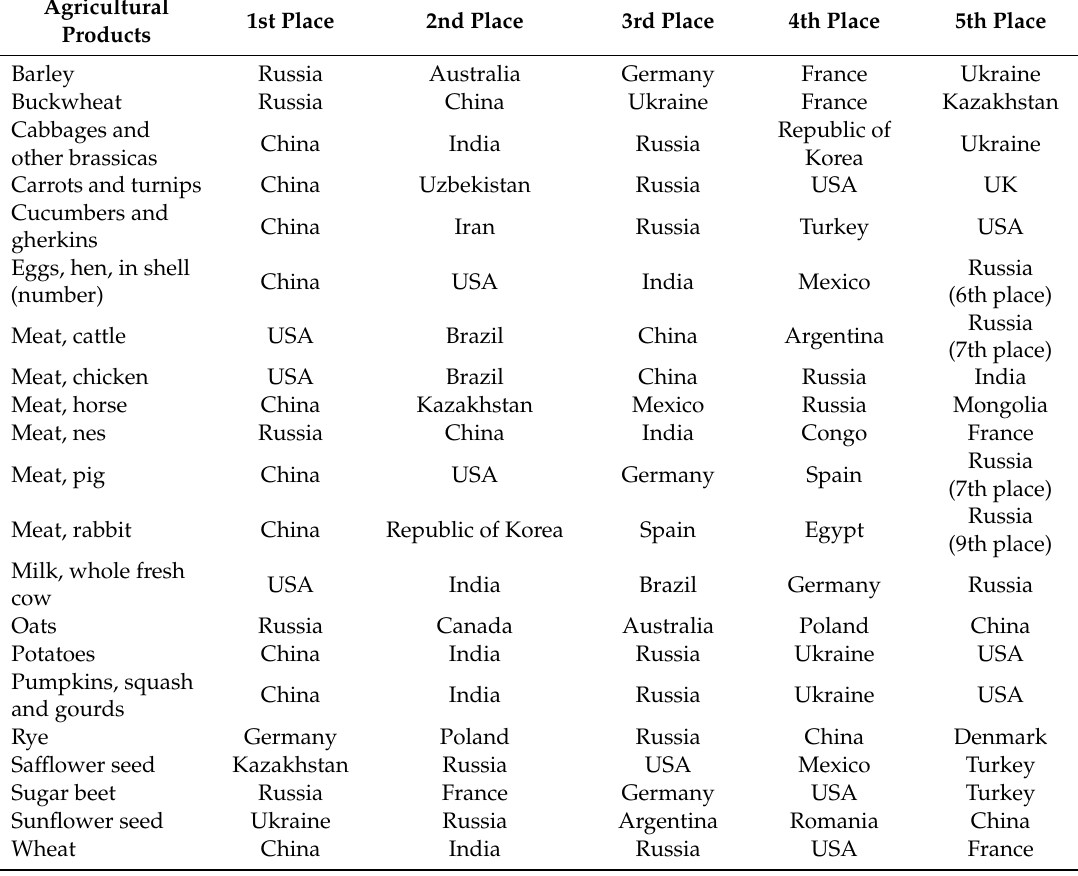
Table 2. World’s leaders in production of agricultural products in 2017 (based on data from